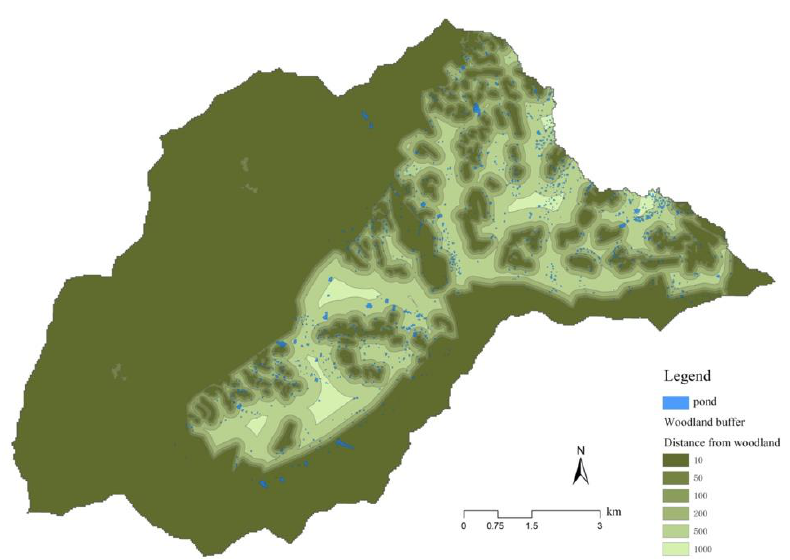
Figure 17. The woodland buffer.